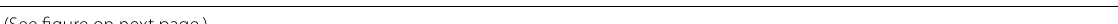
figure on next Fig. 11 The number of detected events of various types in a 15-day interval following the occurrence of the mainshocks. a The number of tremors in 2011 identified in the present study. Time period before ocean-bottom seismometer (OBS) deployment (April 11, 2011) is covered. The vertical dashed lines show the occurrence times of M6.9 and M6.6 earthquakes. b Schematic illustration of aseismic slip behavior as suggested by the tremor activity. c The number of all the regular earthquakes reported by the Japan Meteorological Agency in 2011. The area of the rectangle in Fig. 1 is the same as that for repeating earthquakes. d The number of regular earthquakes reported by Japan Meteorological Agency post the Mw 7.1 Sanriku-Oki earthquake on 2 November 1989. e The number of repeating earthquakes in 2011 (Uchida and Matsuzawa 2013). f The number of repeating earthquakes in 1989 (Uchida and Matsuzawa 2013). g The number of very low frequency earthquakes (VLFEs) recorded in 2011 (Baba et al. 2020). Timings of the seven VLFEs reported by Matsuzawa et al. (2015) are indicated by inverted